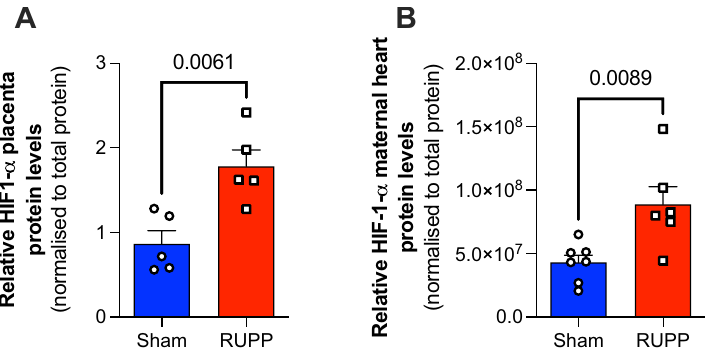
Figure 1. RUPP increases HIF1α expression in placenta and maternal hearts. RUPP leads to increase in HIF-1α protein expression in placenta ( A ) and maternal hearts ( B ). Protein lysates were extracted from placenta and heart from each rat and western blotting performed to determine the expression of HIF-1α relative to the total protein. Two group comparison was carried out using the student t test, n ≥ 5; P values < 0.05 shown in individual